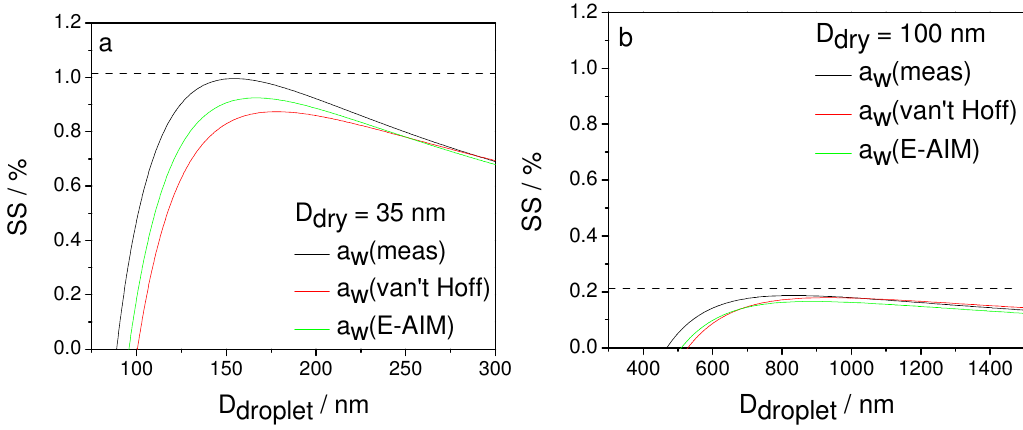
Fig. 6. K¨ohler curves for 50:50 mixtures of citric acid and ammonium sulphate calculated using a water activity based on either measured water activites, constant van’t Hoff factors or modeled results from the E-AIM for two different dry particle diameters, D dry . The surface tension is calculated according to the parameterization in Table 3. The dashed line indicates the critical supersaturation measured with CCNC, listed in Table 6. (a) D dry = 35nm and (b) D dry =